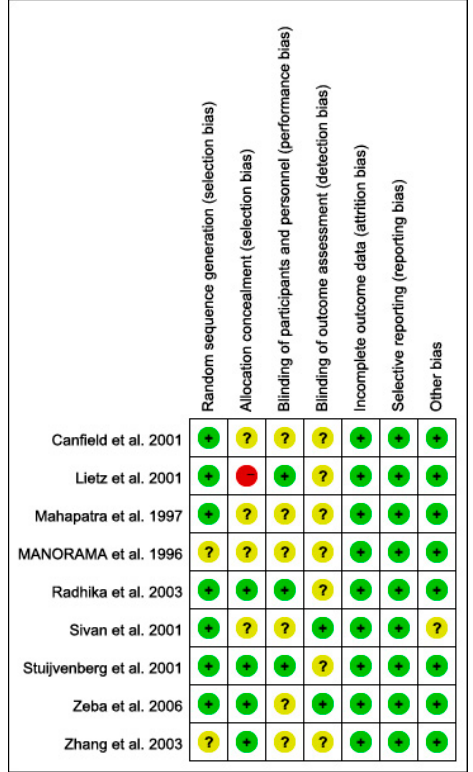
Figure 9. Risk of bias assessment of trials evaluating red palm oil (RPO) on vitamin A deficiency (VAD). Note: +, low risk of bias, ?, unclear risk of bias, − , high risk of bias.